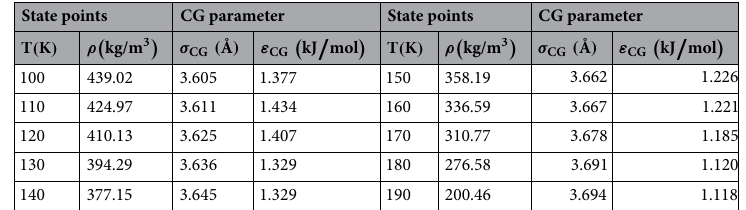
. In the direction of x coordinate axis, the body